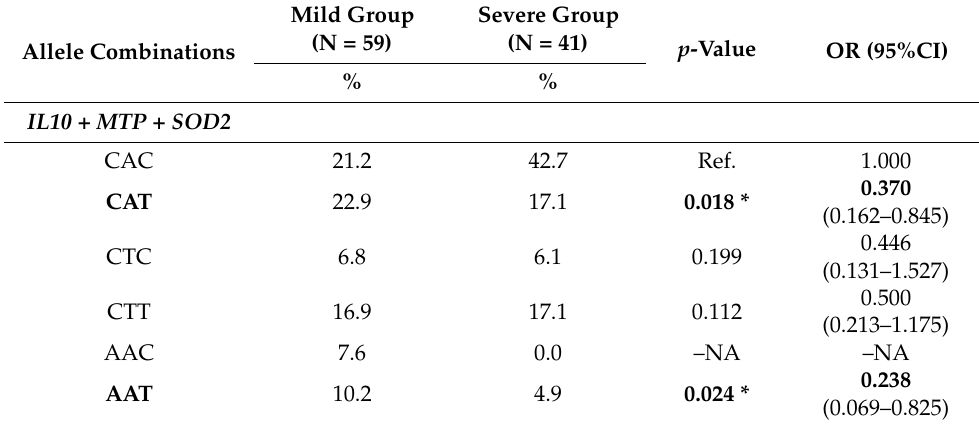
Table 3. Analysis of three-gene combination alternately for alleles of IL-10 -627 (C/A), MTP -400 (A/T), SOD2 1183 (C/T), and APOE (E3, E2, and E4) in Mild and Severe fibrosis